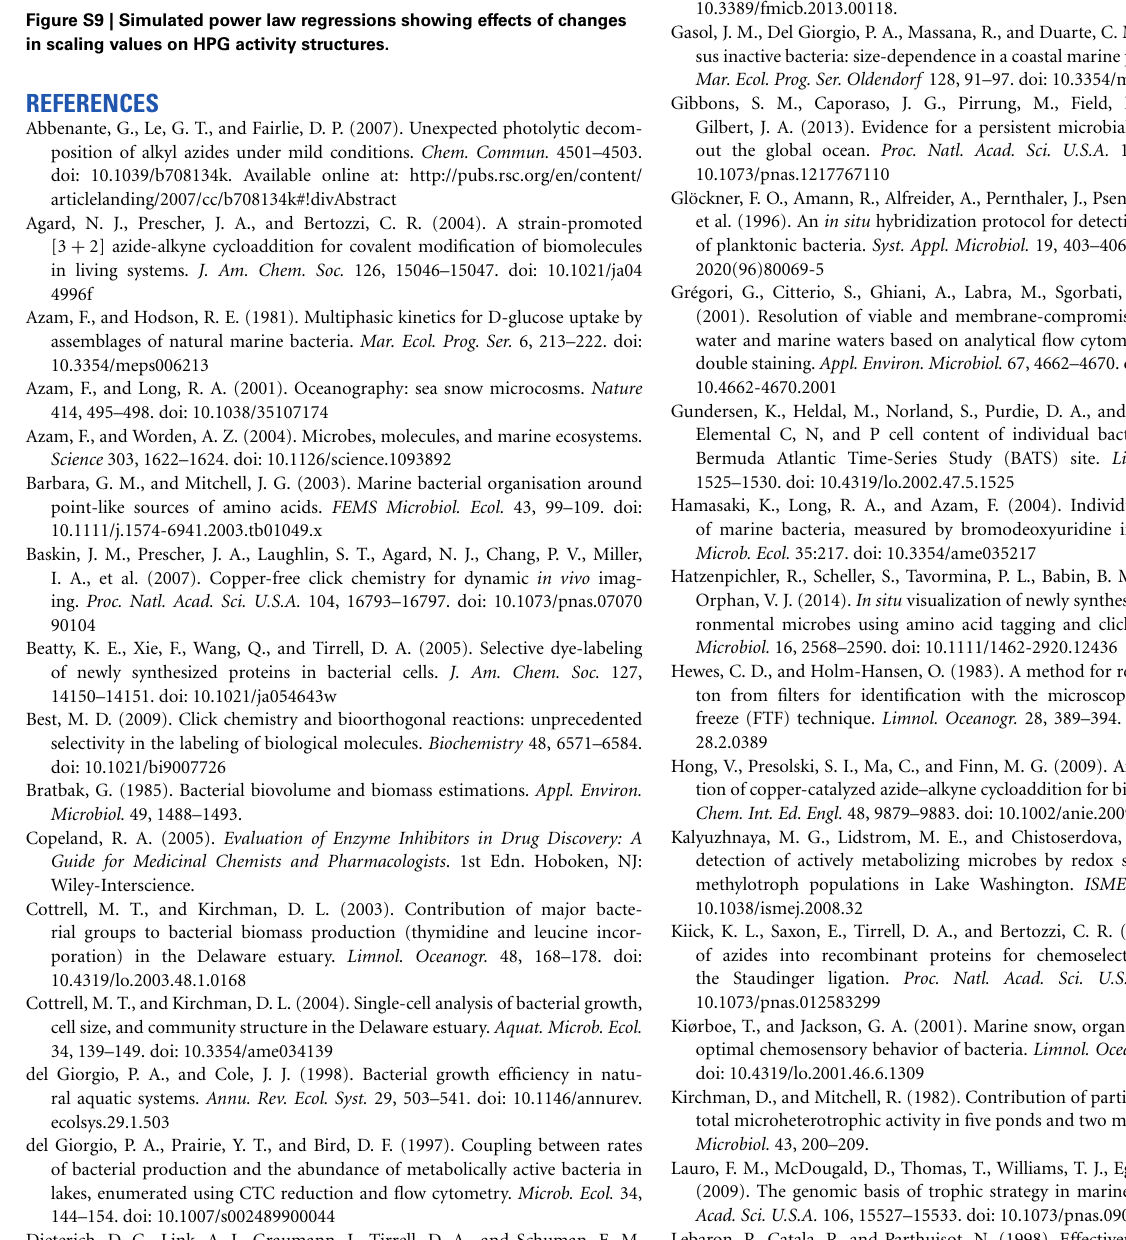
Figure S7 | Composite example images of HPG labeled (green) and DAPI-stained cells (blue) of the free-living (A) and particle-associated (B) communities following incubation for 1h in 20nM HPG. For comparison, the bottom row of images show fixed controls of free-living (C) and particle-associated (D) cells. Insets depict signal in the green channel only. Scale bars = 10 μ m. Figure S8 | Individual cell HPG incorporation in clonal cultures of Alteromonas strains AltSIO (left) and As1 (right). Cultures were initiated in seawater at T = 0h, and at each timepoint shown an aliquot was incubated for 1h with HPG. Means are shown by red bars ± 95% confidence intervals. Blue dashed bars show medians. Note the different intervals between the top and bottom y-axis segments. Figure S9 | Simulated power law regressions showing effects of changes in scaling values on HPG activity